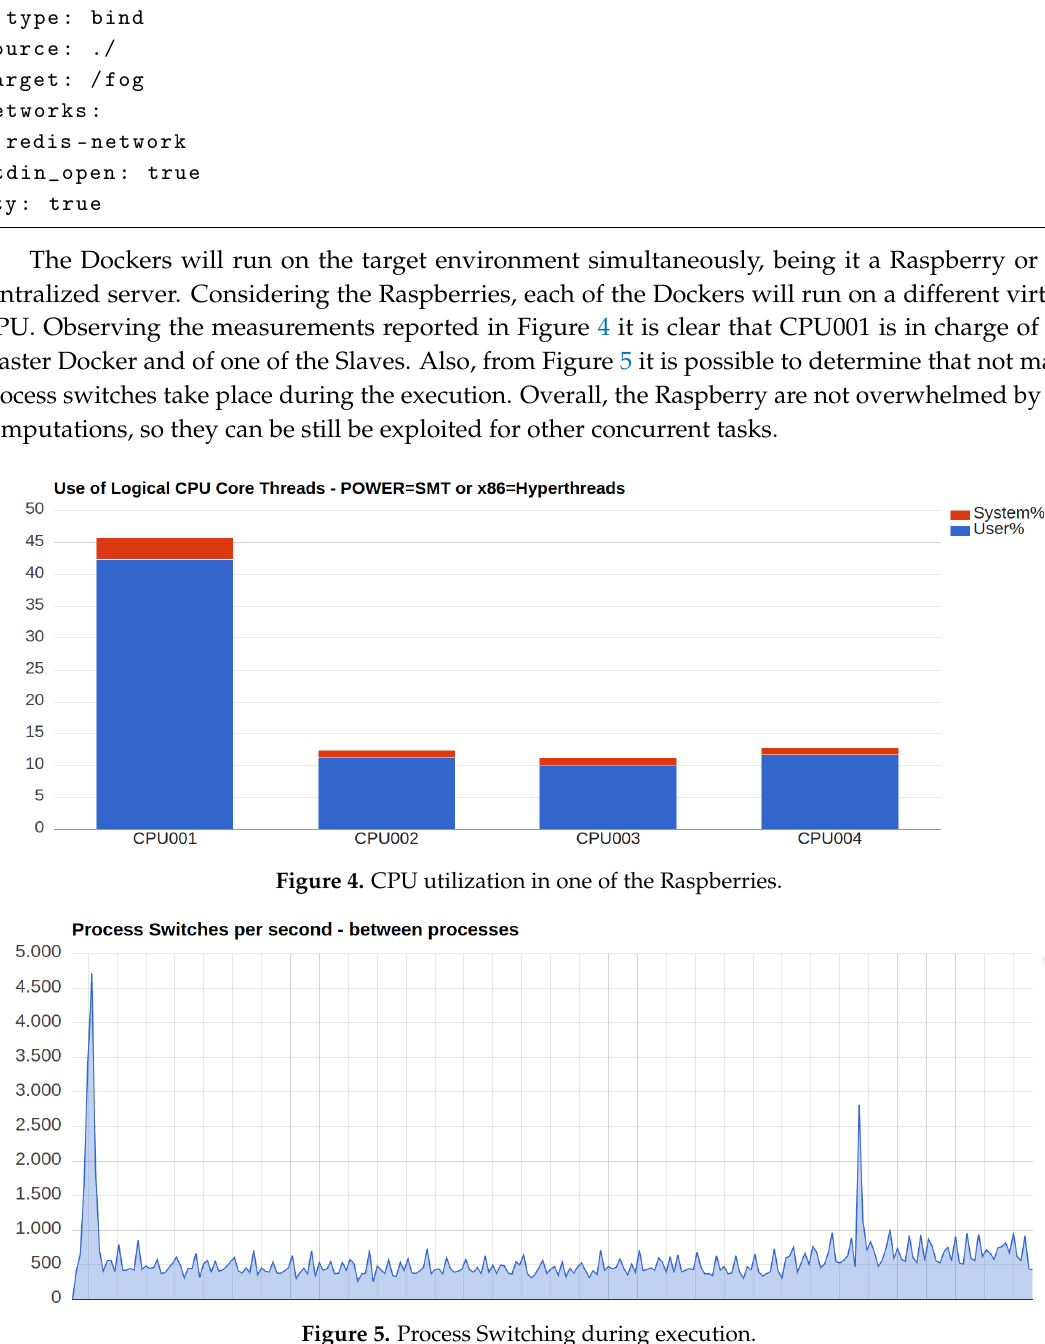
Figure 5. Process Switching during